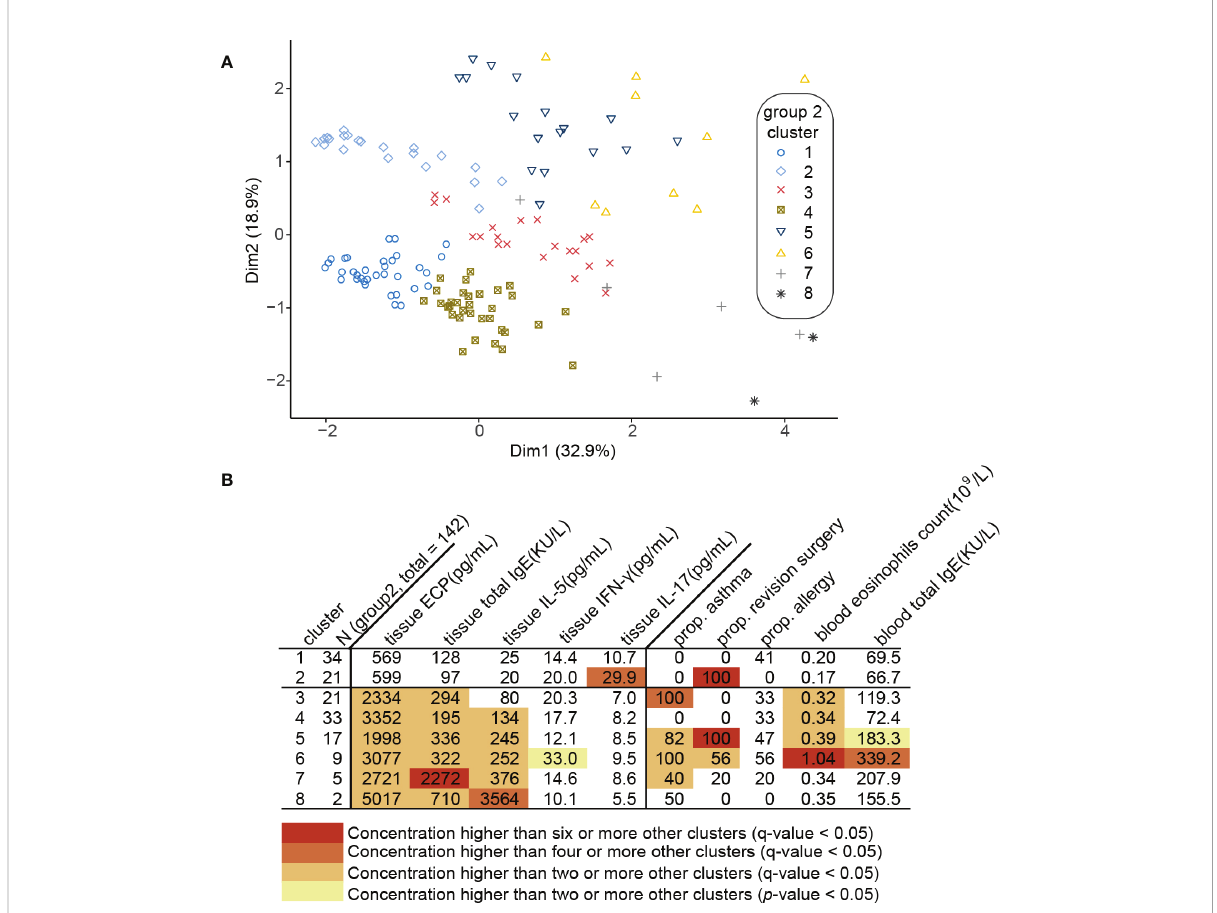
FIGURE 2 Clustering of 142 CRSwNP patients (Group 2). (A) Principal component analysis ( PCA) plot of patients plotted in a 2-dimensional space after multidimensional scaling. (B) Modi fi ed heat map of data relevant to each cluster. Rows de fi ne clusters of patients with CRSwNP. Categorical variables (asthma, allergy and revision surgery) are shown as positive ratio. Continuous variables (tissue biomarkers, blood eosinophils count and blood total IgE) are shown as geometric mean. Each q-value represents Benjamini-Hochberg adjusted p